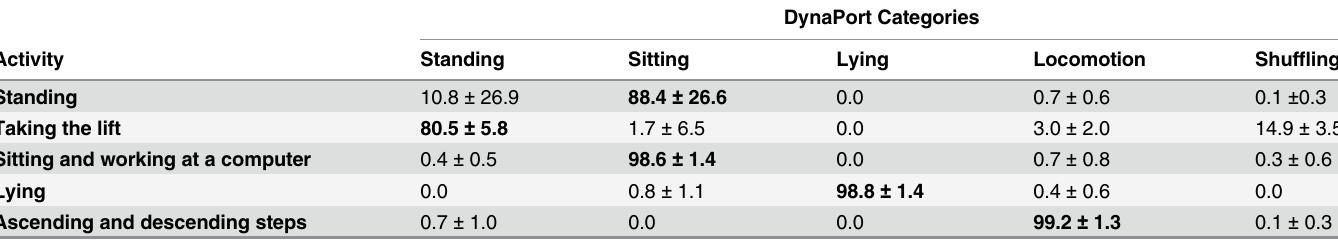
Table 6. Classi fi cation of the performed activities for the Movemonitor